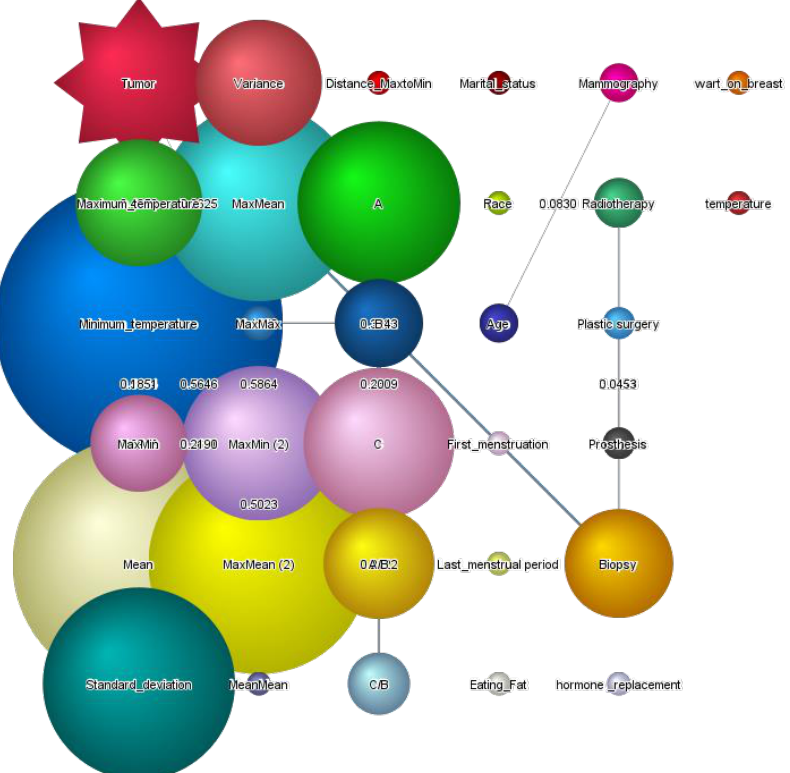
Figure 9. BN structure from unsupervised learning with node strength evaluated with “node force” and Arc strength evaluated with mutual information.